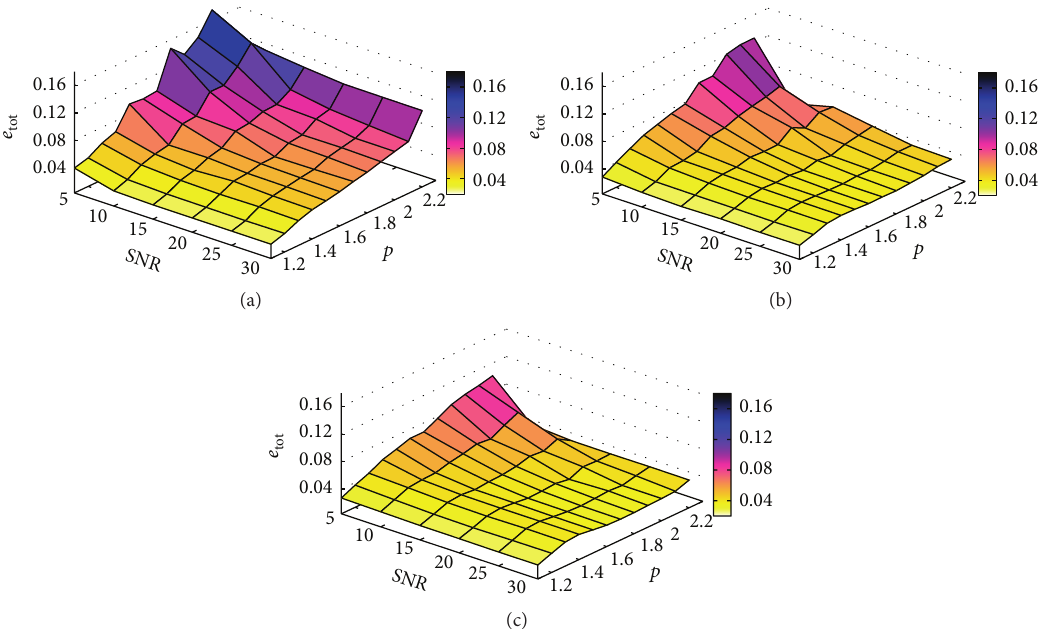
Figure 5: Relative reconstruction error on the investigation domain versus the 𝐿 𝑝 Banach space norm parameter 𝑝 and the SNR, for 𝑆 = 20 : (a) one frequency, 𝐹 = 1 ; (b) two frequencies, 𝐹 = 2 ; (c) three frequencies, 𝐹 = 3 .